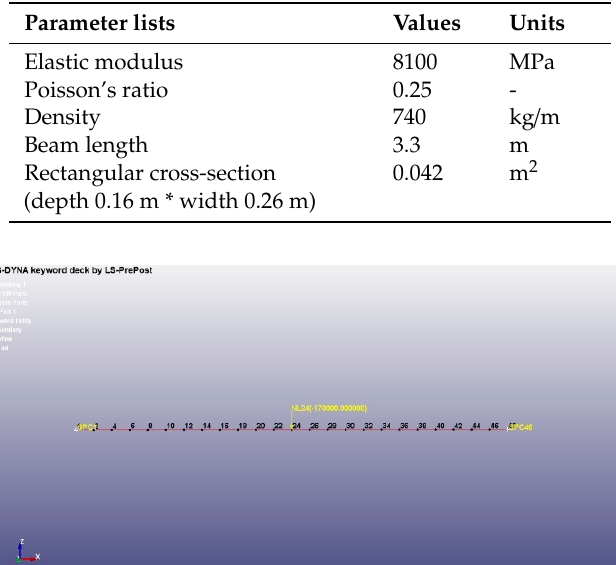
Figure 14. Finite element method for determining deflections of a FFU composite beam under bending loading. 4.3. Validation of the FFU Composite Simulation Model To validate the numerical model of a FFU composite beam components acting as a bearer for switch or crossing areas in the railway system, the analytical solution based on classical beam theory